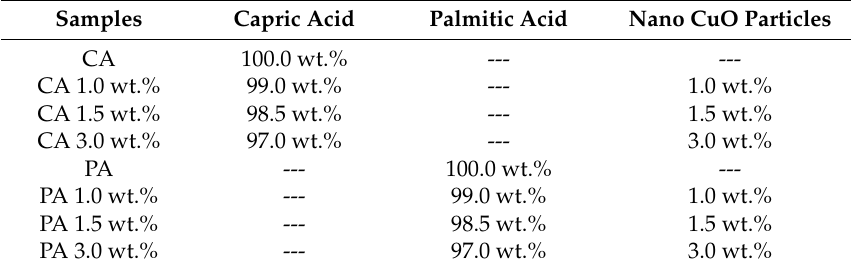
Table 3. List of samples under study.